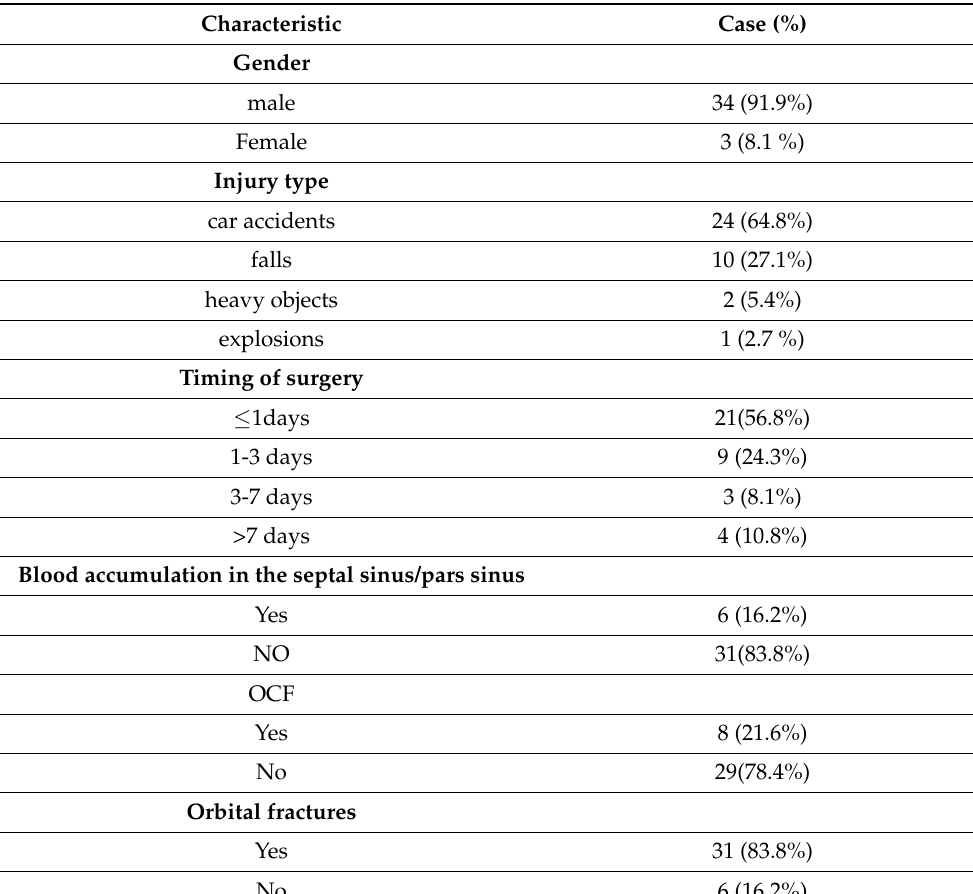
Table 2. Clinical demographic data of the